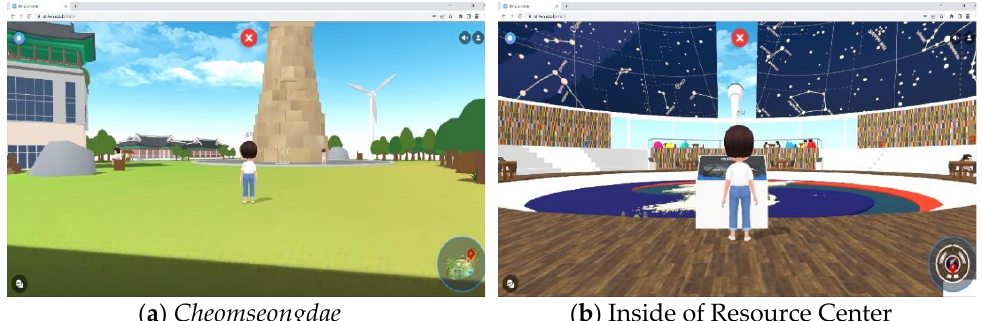
Figure 10. Resource Center.